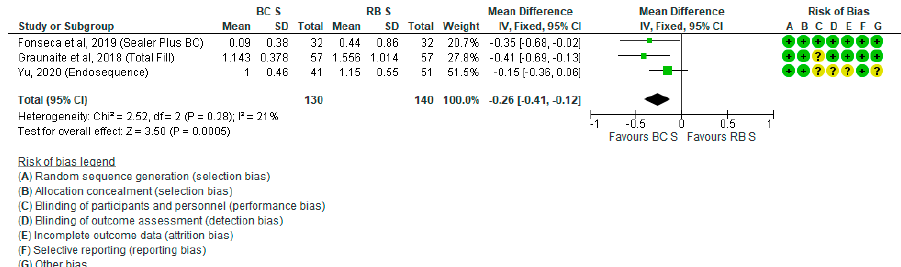
Figure 2. Forest plot of POP level 24 h after RCF with BCS vs. RBS.